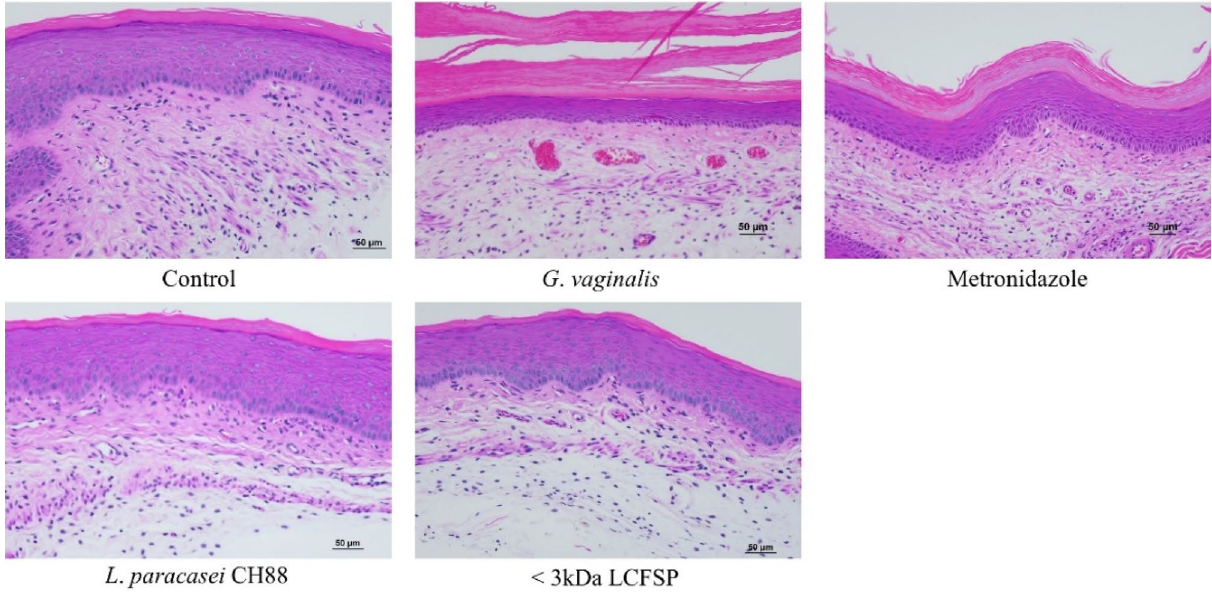
Figure 6. Hematoxylin–eosin staining of the murine vaginal tissue intravaginally treated with phosphate- buffered saline (20 μL), G . vaginalis (1 × 10 8 CFU), metronidazole (100 μg), Lactobacillus paracasei CH88 (1 × 10 10 CFU), and protein fraction below 3 kDa of L. paracasei CH88 cell-free supernatant (20 μg; < 3 kDa